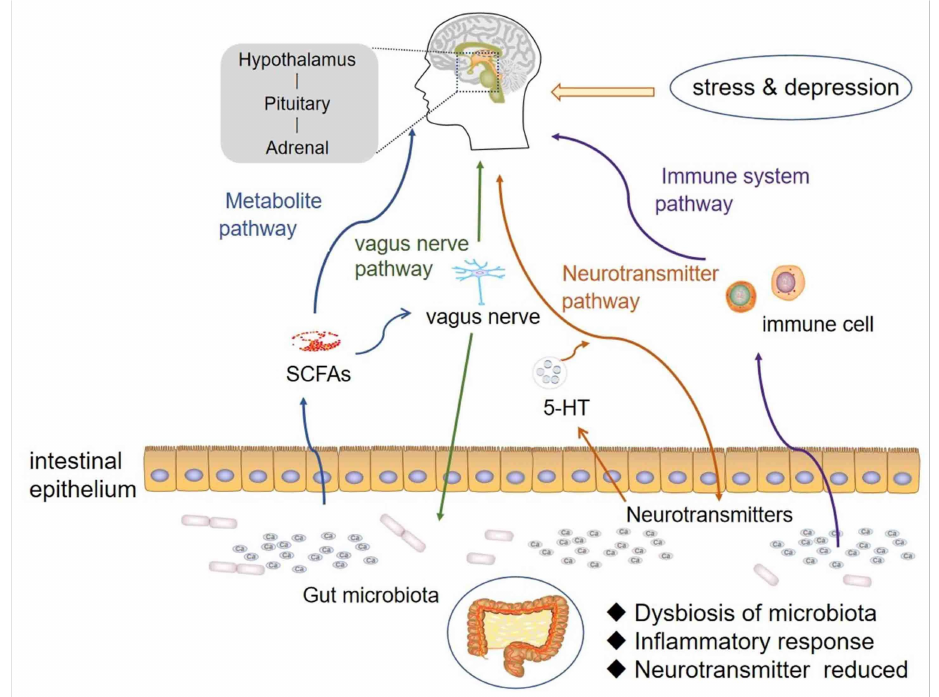
Figure 1. The bidirectional regulation mechanism of